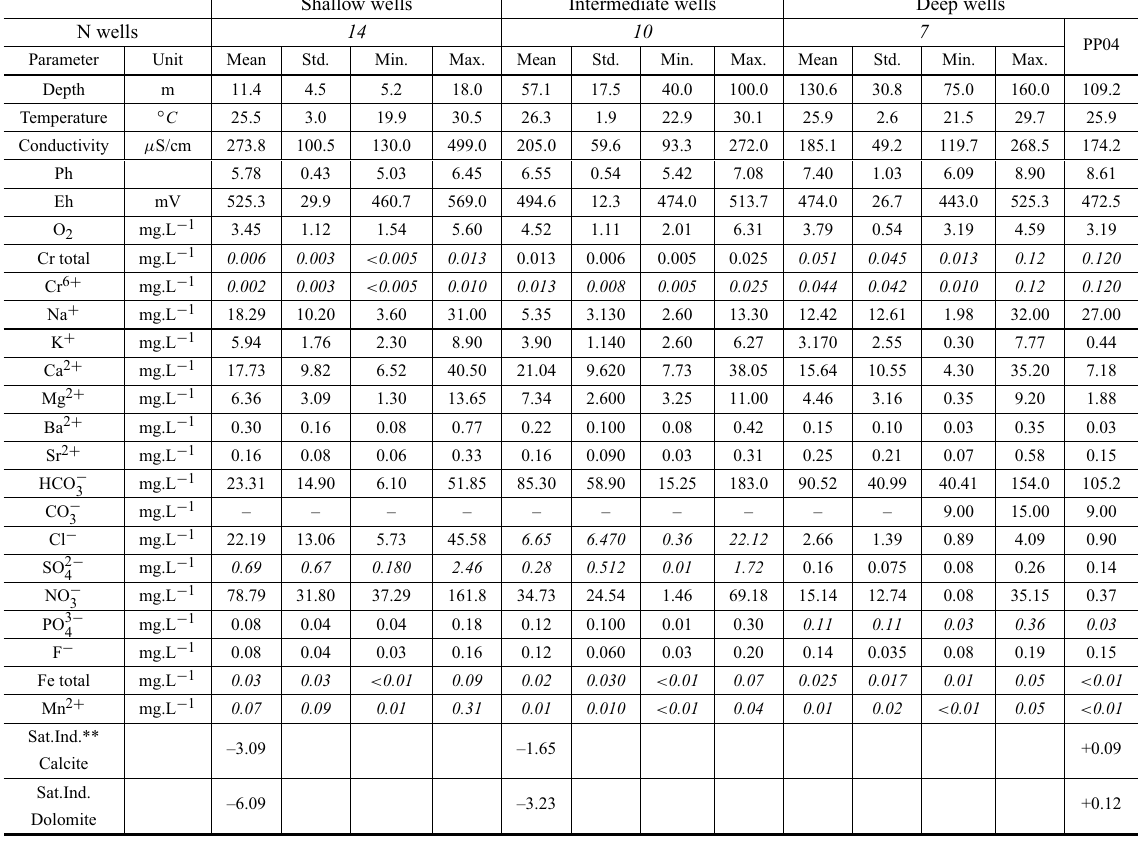
Summary of analytical data of groundwater in shallow, intermediate and deep wells studied in the municipality of Urânia (four rounds of sampling from June 1998 to June